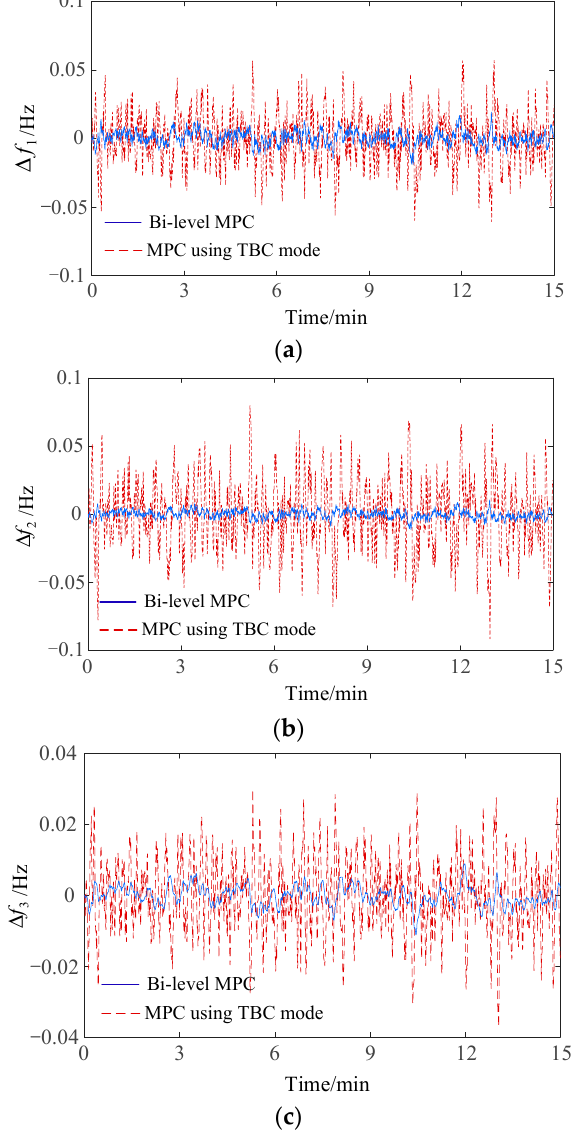
Figure 9. Frequency deviation of three-area system under output power of wind power random disturbance: ( a ) Area 1; ( b ) Area 2; ( c ) Area